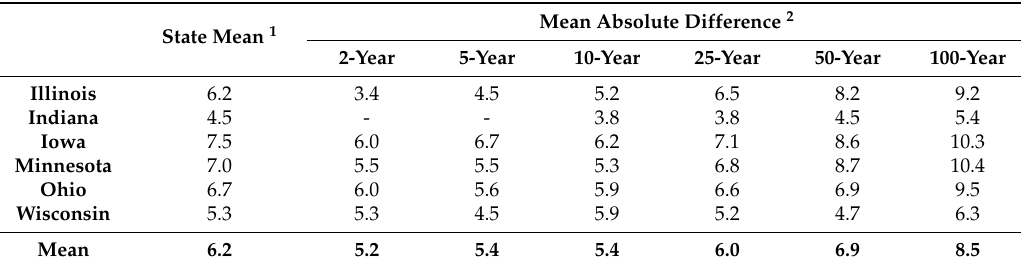
Figure 4. For the Log-Pearson Type 3 approach, the ratio of the calculated versus expected occurrences based on the mean discharge of all 150 catchments evaluated ( A ); and the mean discharges for the 25 catchments in each state ( B ). Solid circles and dashed lines are associated with occurrence ratios based on 125% of the discharges calculated with the Log-Pearson Type 3 analysis. Also shown is the ratio of the calculated versus expected occurrences based on the mean discharge for the 25 catchments evaluated in Indiana ( C ) and the ratios determined with the discharge for each of the 25 catchments evaluated in Indiana ( D ). Table 5. Absolute values of the mean percent difference between the calculated and published discharges for 2-year to 100-year recurrence interval for each state. For Indiana, values for the two-year and five-year values are not reported